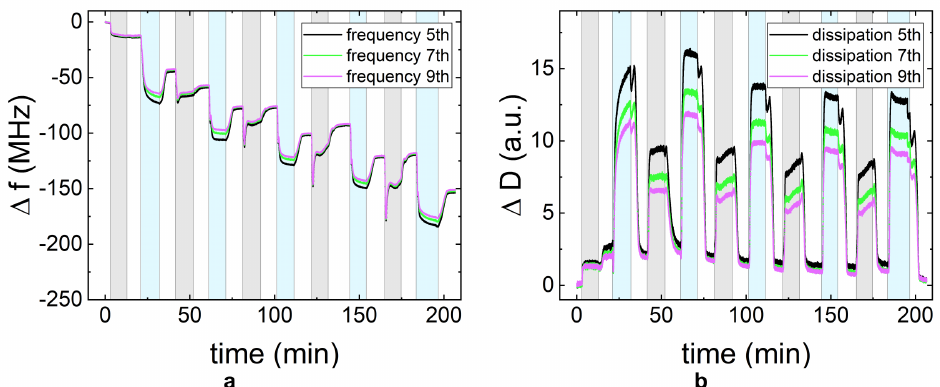
Figure 6. The change in frequency ∆ f ( a ) and dissipation ∆ D ( b ) measured by QCM-D for the PEM PDADMAC/CMC at 5g/L. The gray region is the time period during which the polycation is adsorbed, the blue region in which the polyanion is adsorbed, and white for the rinsing periods. The different curves in one plot represent different overtones of the measured intensity (5th, 7th, and 9th). The pH-value was maintained at pH =